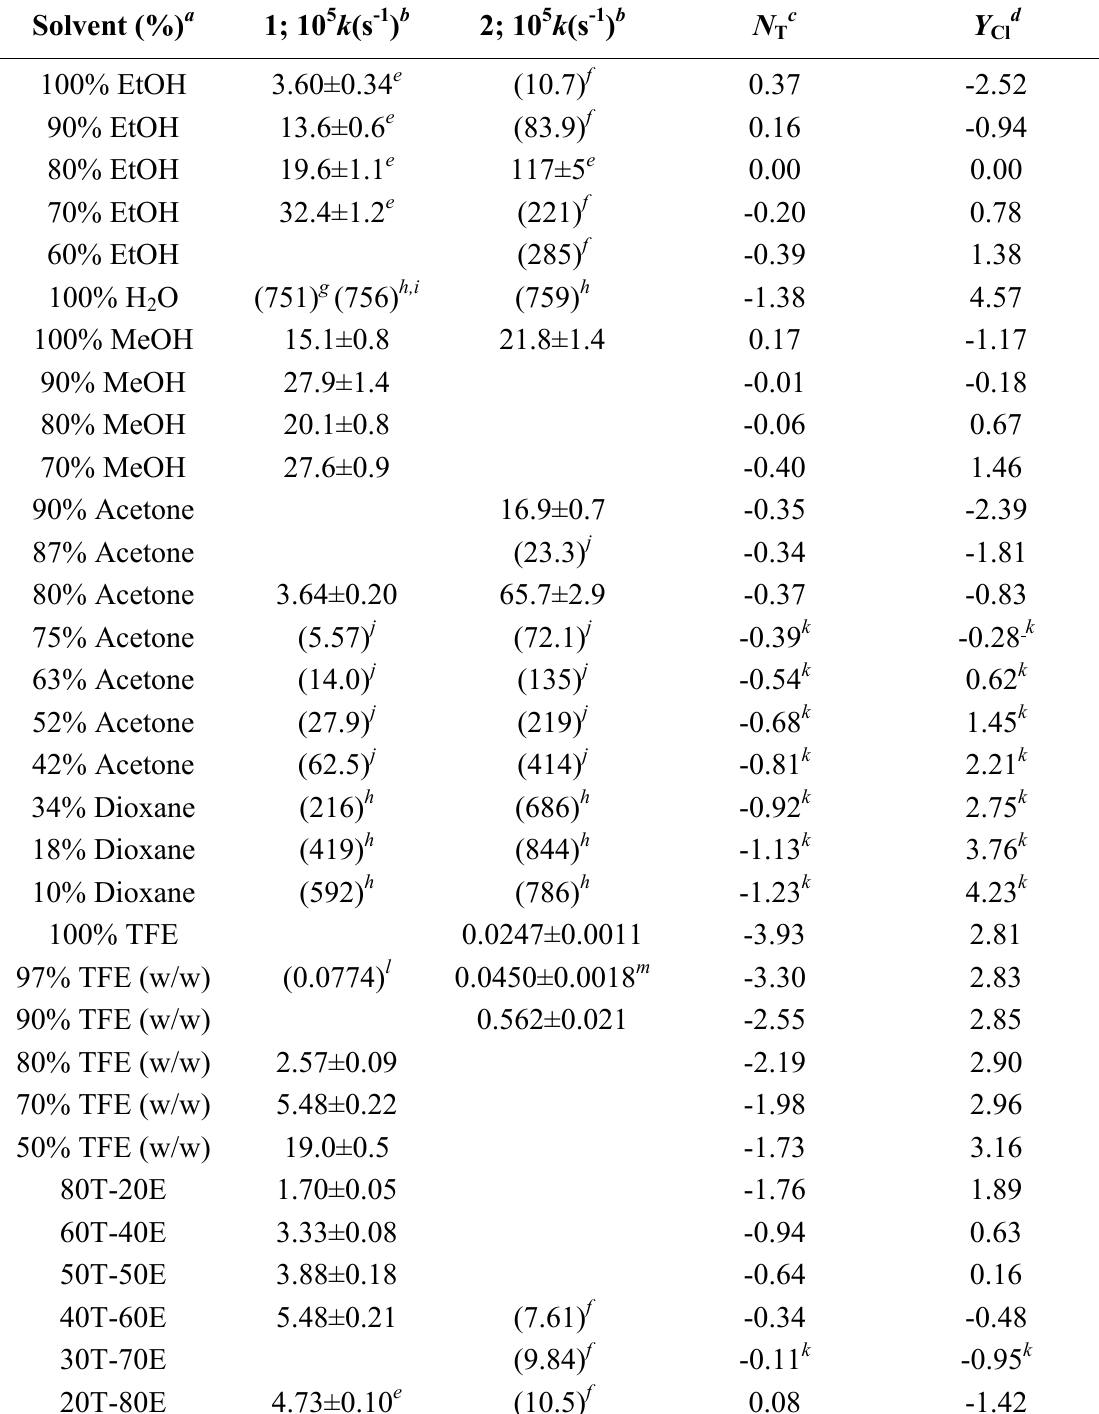
Table 1. Specific rates of solvolysis ( k ) of benzenesulfonyl chloride ( 1 ) and p – nitrobenzenesulfonyl chloride ( 2 ) in pure and binary solvents at 35.0 ºC and the solvent nucleophilicity ( N ) and solvent ionizing power ( Y ) values for the T Cl